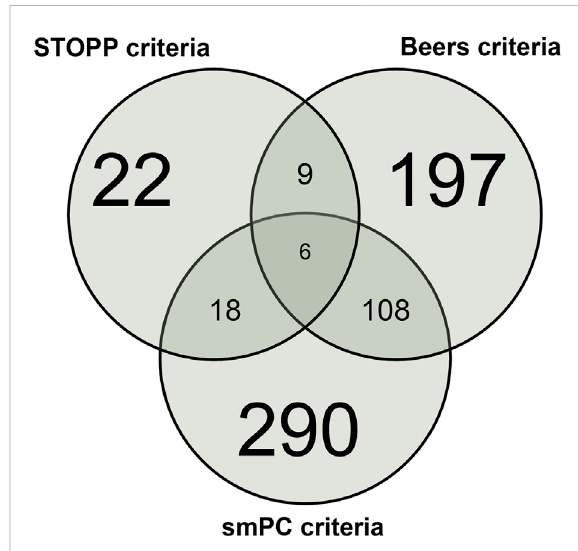
FIGURE 1 Venn diagram showing the overlap between STOPP, Beers, and smPC PIM in the overall